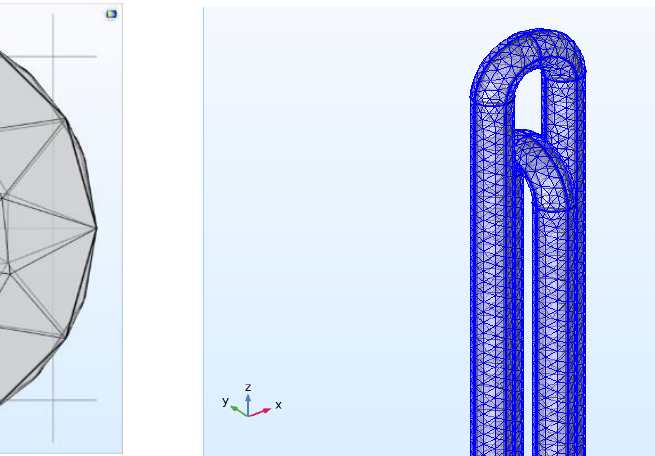
Figure 3. Element size for meshing Figure 4. A double U-tube